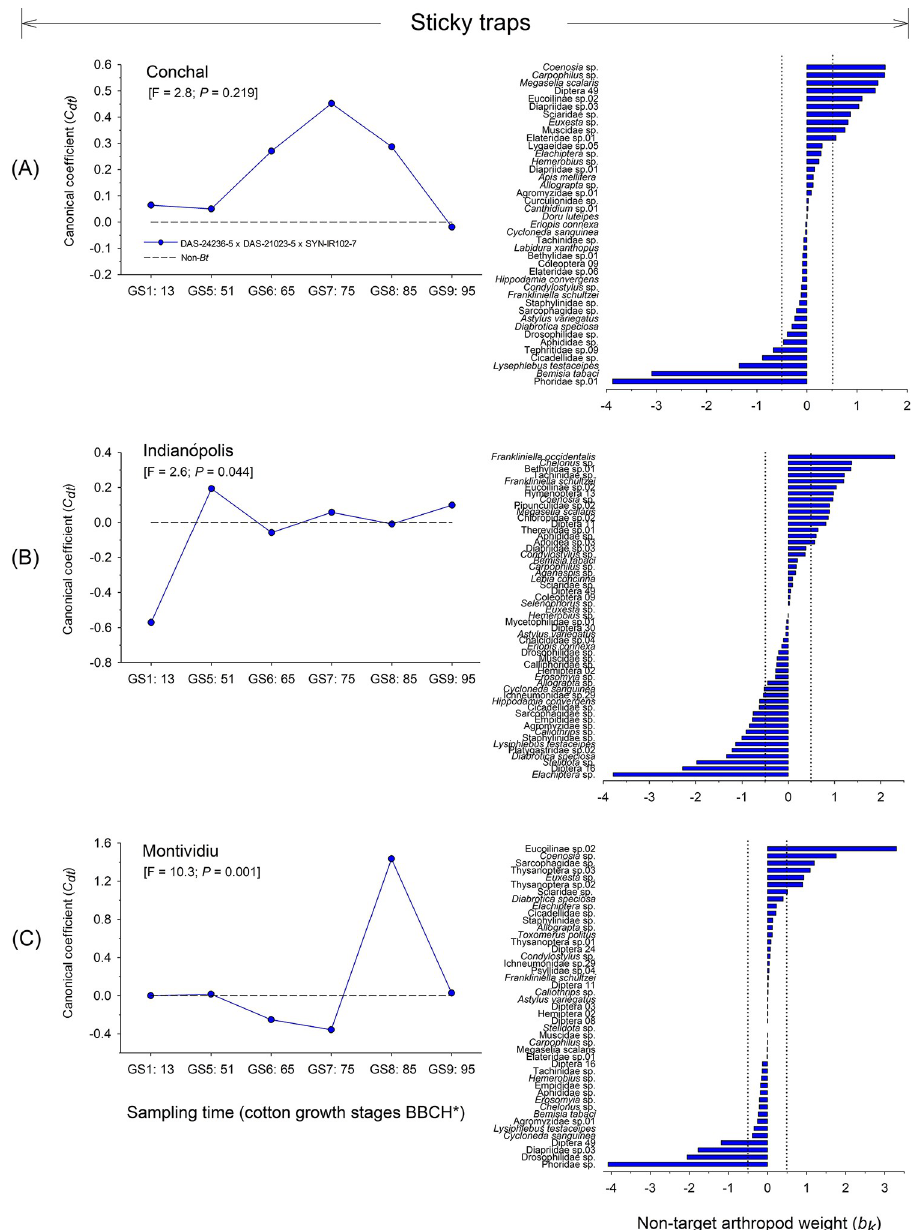
Fig 6. Principal response curves (PRCs) and taxon weights of aerial-dwelling arthropod populations collected via sticky card trapping from DAS-21023-5 × DAS-24236-5 × SYN-IR102-7 Bt cotton compared with a non- Bt variety at three sites in Brazil (2014/2015 cropping season). Dotted line indicates the response within the non- Bt cotton entry. If a significant P-value was detected ( < 0.05, Monte Carlo test), taxa with positive weights followed the PRC pattern, whereas those with negative weights showed the opposite pattern. Taxa with weights between approximately -0.5 and 0.5 did not contribute significantly to the overall pattern. If a P-value was non-significant, species patterns were random in relation to treatments. � Phenological growth stages of cotton classified according to Munger et al. (1998).